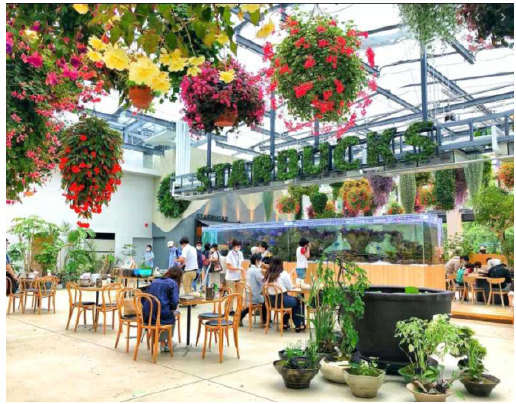
Figure 33. Hana Biyori, Starbucks collaboration store [84].